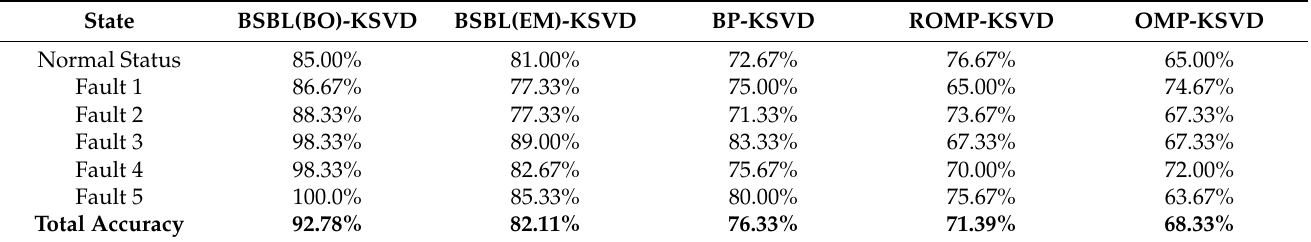
Table 5. When CR = 0.75, the comparative analysis of fault classification of different compression and reconstruction